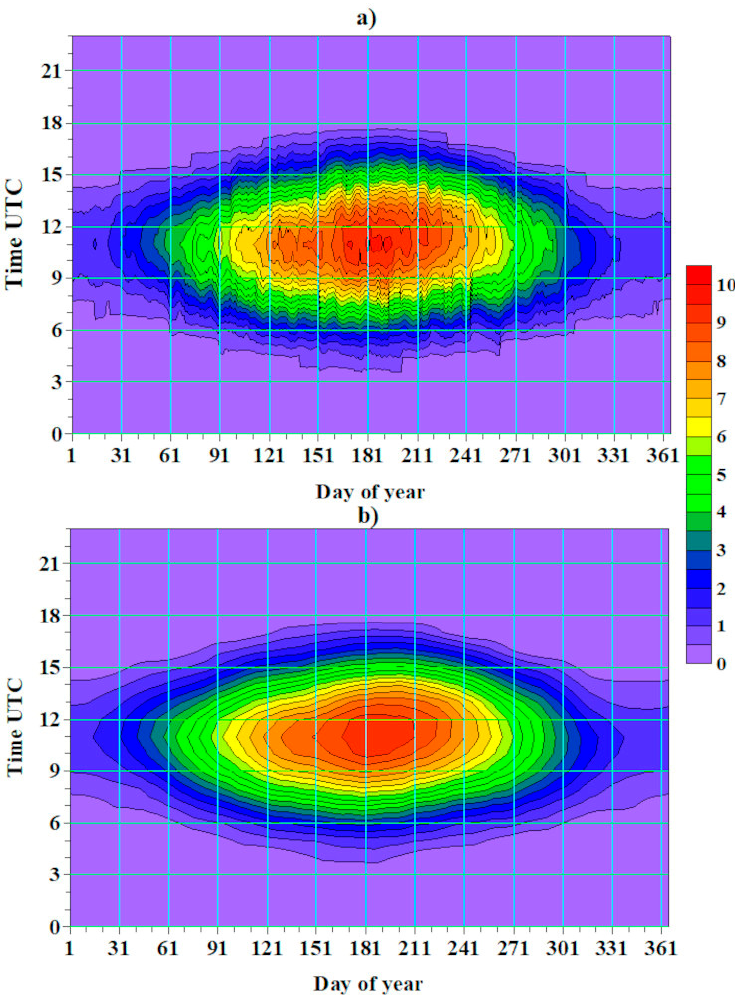
Figure 5. ( a ) Diurnal and seasonal variability of the estimated UV-Index values in clear weather, obtained according to the proposed methodology from the data and ( b ) 31-day running mean.